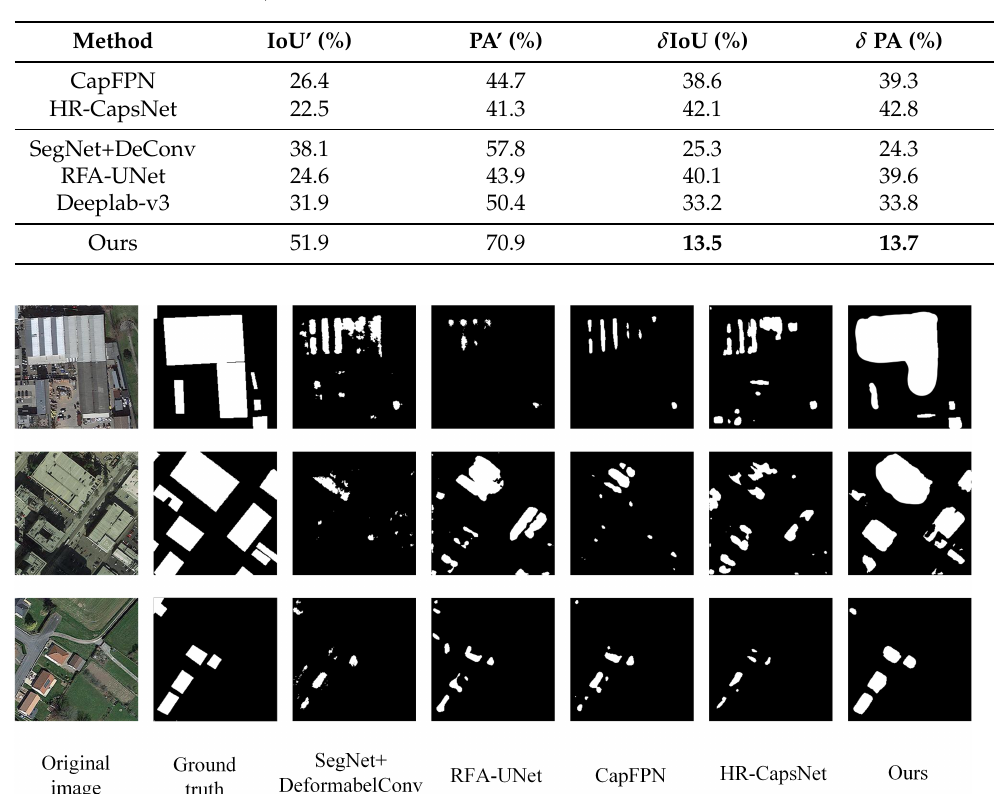
Table 5. Performance of different building extraction methods on the WHU dataset (Yellow River dataset as source domain).